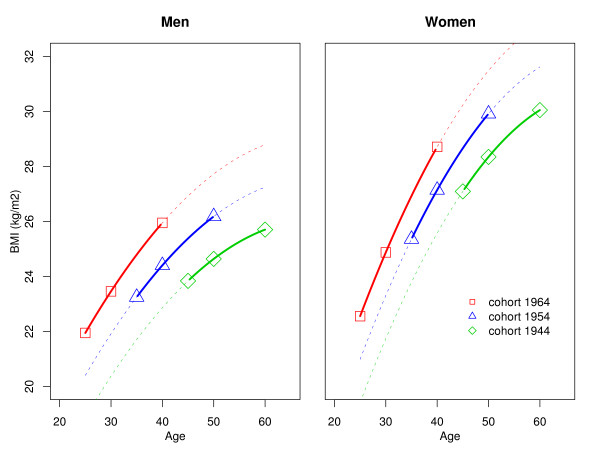
BMI trajectories according to age and birth cohort in men and women, as predicted by linear regression. Models include a quadratic term for age and are not adjusted for other covariates. Years of birth for the cohorts displayed (1944, 1954, 1964) are arbitrary but maximize the ranges of participants' ages during which predicted BMI values are based on data estimated from the underlying surveys (plain lines) vs. extrapolated predicted values (dotted lines).